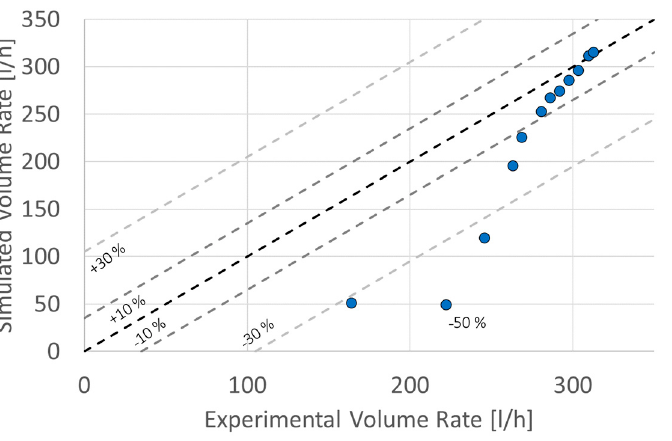
Figure 13. Percentual differences between the simulated data with DFBI and experimental results.